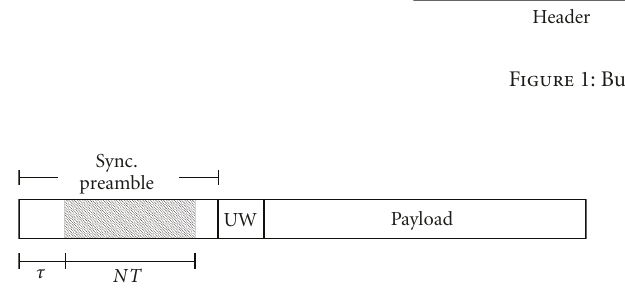
Figure 2: Start of burst estimation